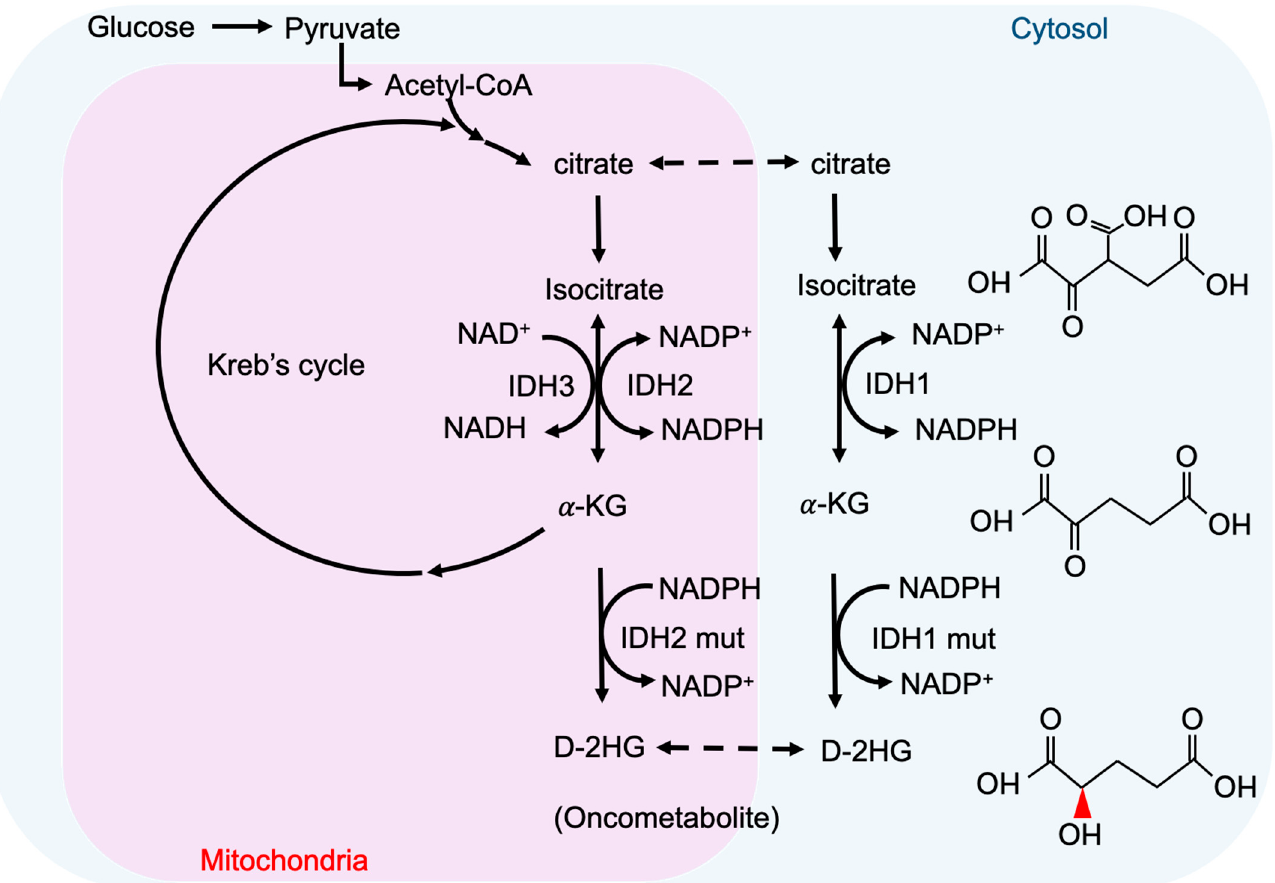
Figure 1. IDH mutations and production of D-2-HG. IDH1 and IDH2 are NADP + dependent enzymes and distribute in the cytosol and mitochondria, respectively. IDH3 is a NAD + dependent enzyme that locates in mitochondria. Mutations of IDH1 and IDH2 enzymes are sufficient to convert a-KG to D-2HG. NADP, nicotinamide adenine dinucleotide phosphate, NADPH, the reduced form of NADP.